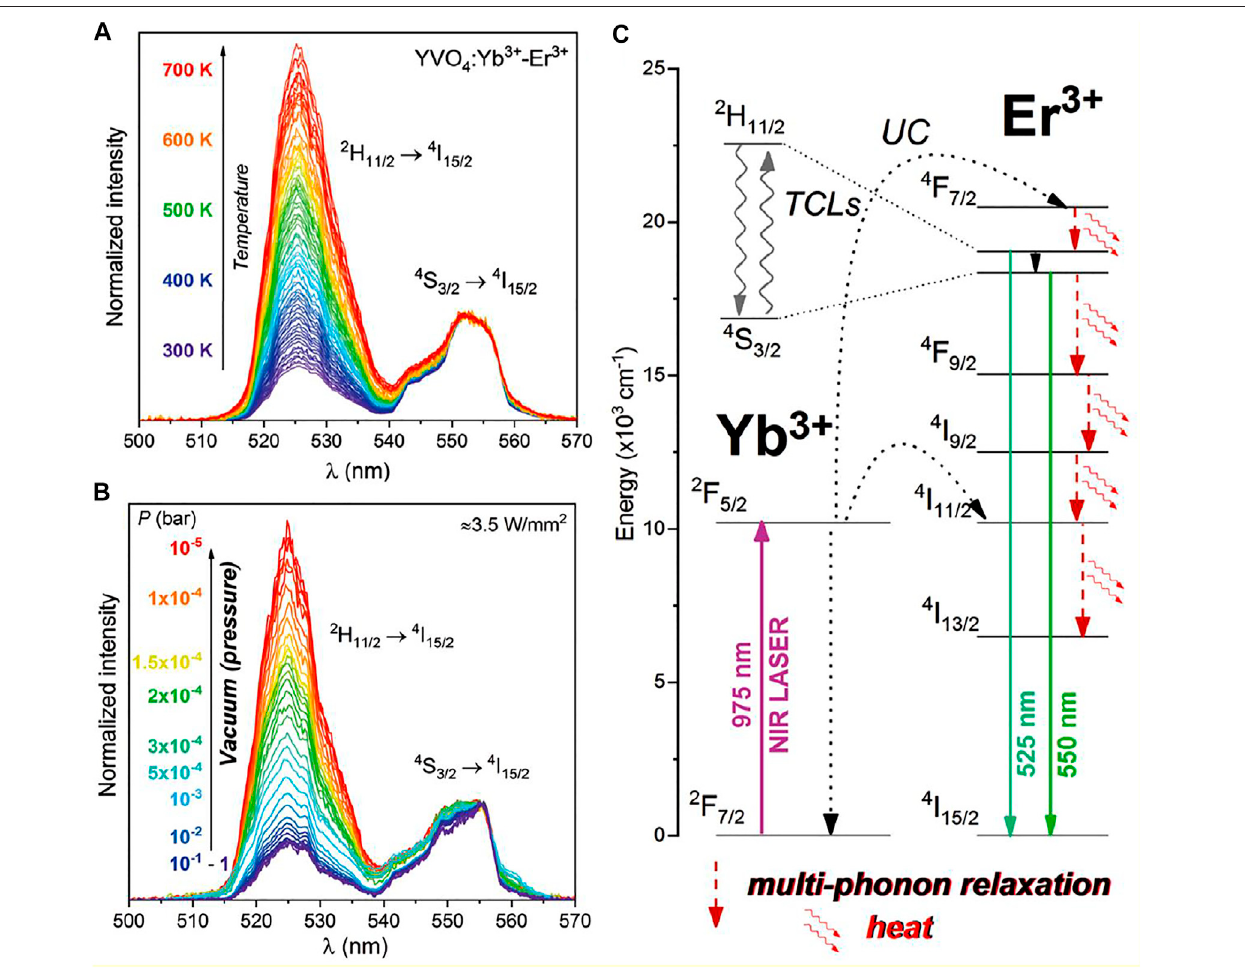
FIGURE15|(A) UCemissionspectraoftheYVO 4 :Yb-Ersample,normalizedtothe 4 S 3/2 → 4 I 15/2 transition; λ ex (cid:2) 975 nm( ≈ 0.5 W mm − 2 ). (B) UCemissionspectra recorded in the pressure range from ≈ 10 – 5 to 1 bar, with power density ≈ 3.5 W mm − 2 ; λ ex (cid:2) 975 nm and (C) radiative and nonradiative processes occurring in the material studied, emphasizing thermalization of states and multiphonon relaxation (Runowski et al., 2020b).